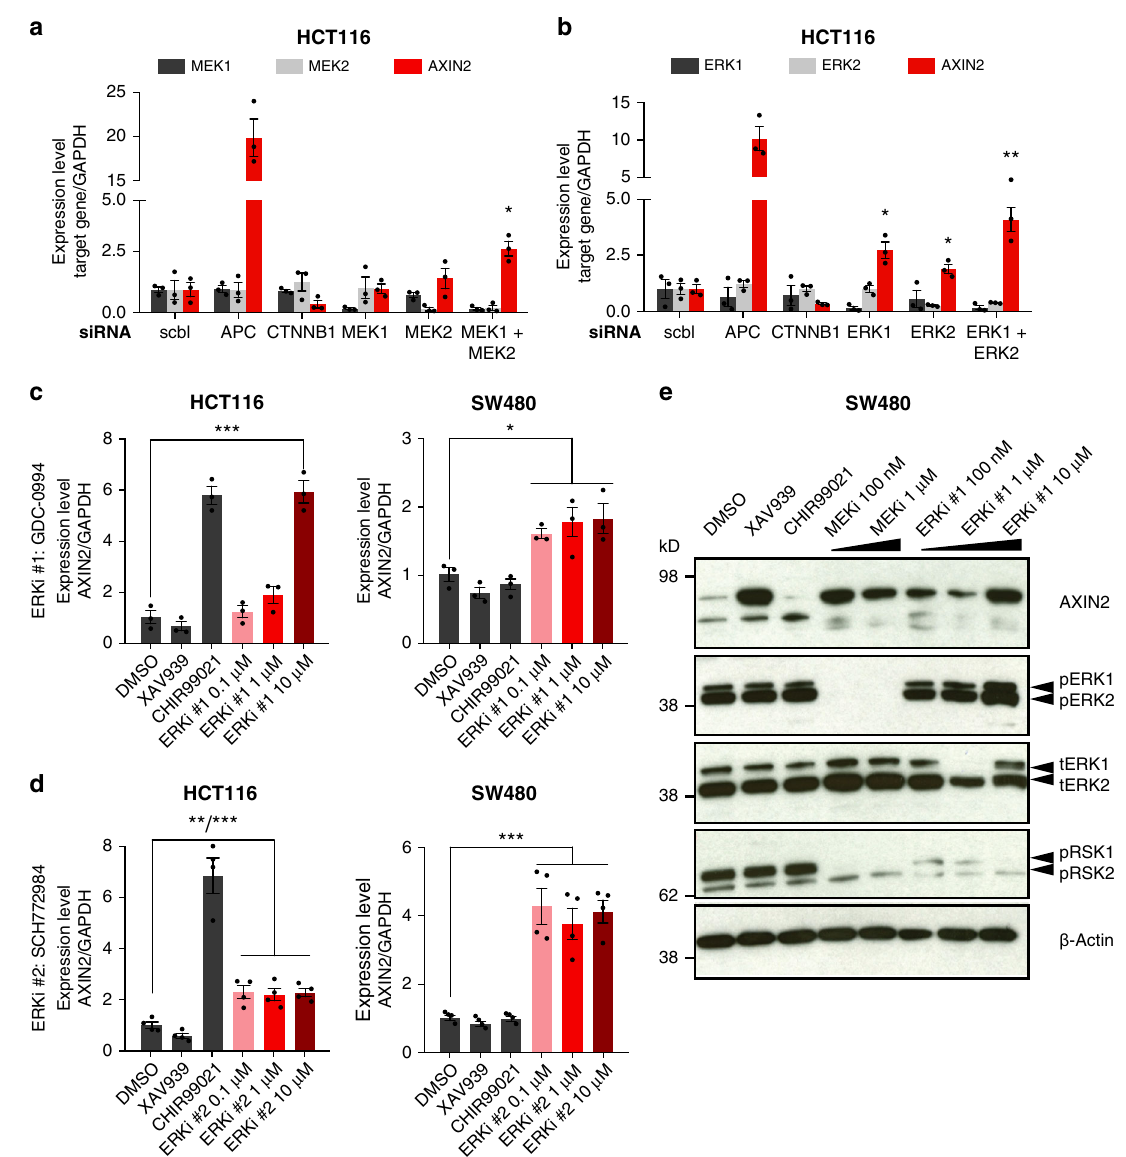
Fig. 3 Inhibition of MEK and ERK by RNAi and small molecules activates canonical Wnt. a – b siRNA mediated knockdown of MEK1/2 and ERK1/2 activates Wnt signalling. HCT116 cells were transfected with the indicated siRNAs for 72 h, followed by measurement of expression levels of target genes by qPCR. The ef fi ciency of individual siRNAs is shown in Supplementary Fig. 2. Data from three independent experiments are presented as mean ± s.e.m. scbl: scrambled siRNA. c – e Small molecule inhibitors of ERK1/2, GDC-0994 and SCH772984, activate the Wnt pathway. HCT116 and SW480 cells were treated with different concentrations of GDC-0094 (ERKi #1) ( c ) or SCH772984 (ERKi #2) ( d ) for 24 h. Transcript levels of AXIN2 were measured by qPCR and data from three or four independent experiments are presented as mean ± s.e.m. Protein levels of AXIN2 and of RAS-MAPK cascade components ERK and RSK were determined by Western Blot in trametinib treated SW480 cells ( d ). A representative Western Blot of three independent replicates is shown. Dependence of MEK inhibitor induced Wnt activation on β -catenin is shown in Supplementary Fig. 4. * p < 0.05, ** p < 0.01, *** p < 0.001, two-sided Student ’ s t (Supplementary Fig. 7D). In all lines, EGR1 expression was strongly repressed upon MEK inhibition. Finally, we analysed if transient overexpression of EGR1 could rescue downregulation of AXIN1 expression by MEK inhibitors. HCT116 were either mock-transfected or transfected with an expression plasmid encoding mCherry or EGR1 , which resulted in an overexpression of the respective genes. Upon treatment with trametinib, both EGR1 and AXIN1 levels decreased in the mock-transfected controls and mCherry expressing cells. In contrast, EGR1 levels were only mildly reduced in cells overexpressing EGR1 , with AXIN1 transcript levels remaining unchanged (Supplementary